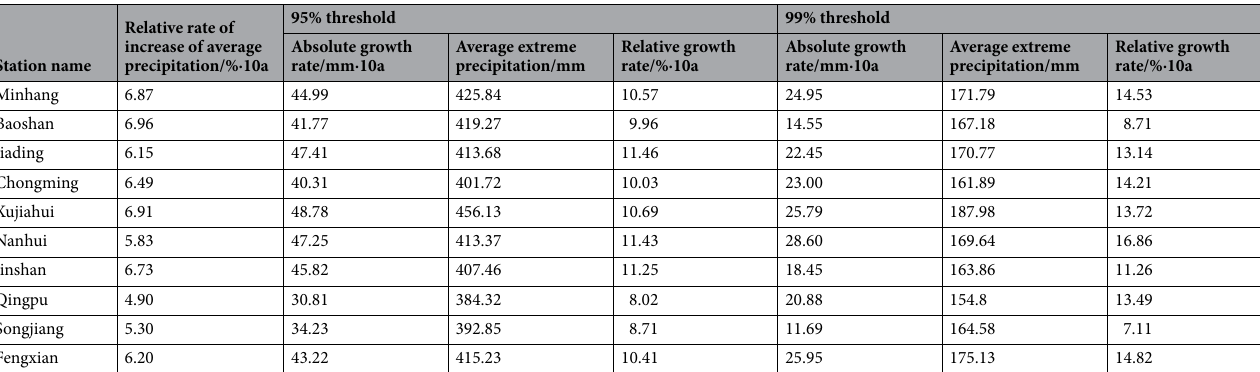
Table 5. Relative growth rate of extreme precipitation under different threshold conditions at each